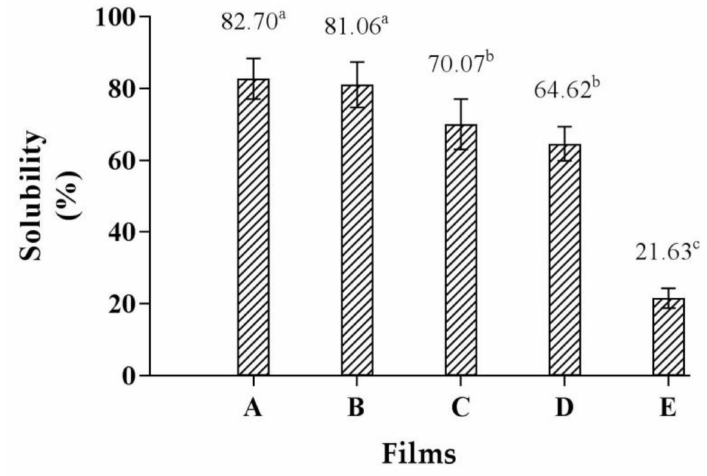
Figure 4. Film solubility of ( A ) CMCy film, ( B ) CMCy75/RF25 composite film, ( C ) CMCy50/RF50 composite film, ( D ) CMCy25/RF75 composite film, and ( E ) RF film. Bars represent the standard deviation ( n = 3). Different letters indicate the significant difference ( p < 0.05).